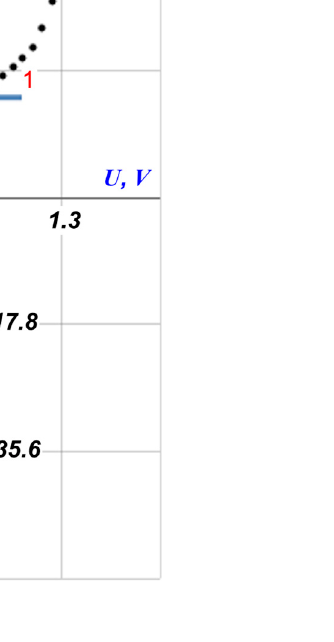
Figure 6. The dependence of the differential conductivity κ (curve 1) and the ratio ( h 1 + h 2 ) I/U (curve 2) of the bilayer membrane MF-4SC/PTMSP in 0.05M HCl solution, on the current density I .